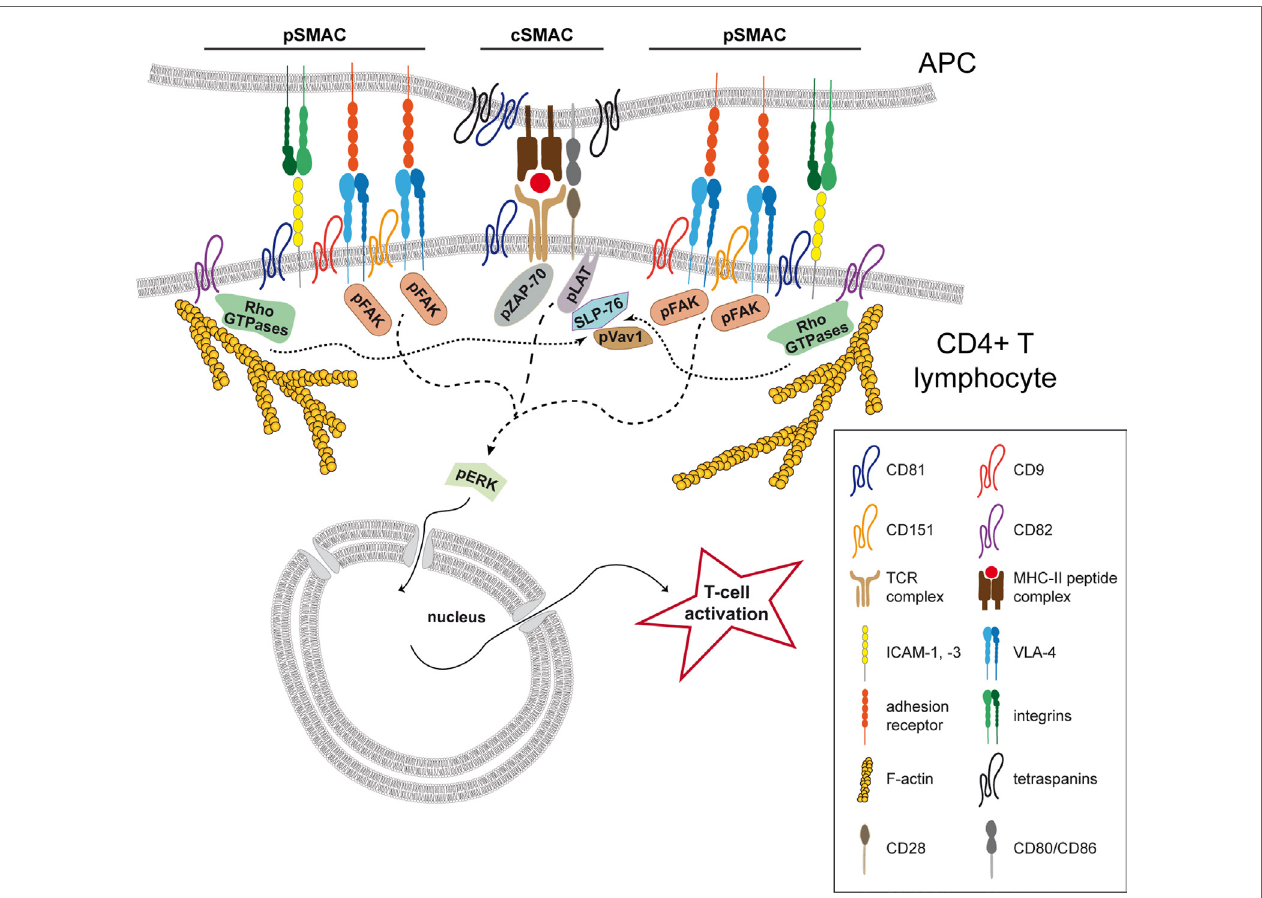
FiGURe 2 | Tetraspanins organize the T-cell immunological synapse . Tetraspanin CD81 regulates the organization of the immunological synapse (IS) in CD4 + T lymphocytes through the association with CD3 ζ at the central SMAC (cSMAC). CD81 controls the localization of the TCR complex and its downstream signaling, positively modulating the phosphorylation of ZAP-70, LAT, and ERK1/2 (dashed line). At the peripheral area of the cell–cell contact (pSMAC), tetraspanins CD9, and CD151 are important for integrin VLA-4 relocalization and activation, positively regulating the integrin downstream phosphorylation of FAK and ERK1/2 (lines with small dashes). At this location, CD81 also interacts with the adhesion receptor ICAM-1, regulating its segregation during IS maturation. Tetraspanin CD82 accumulates at the pSMAC and triggers actin polymerization and the activation of the Rho GTPase pathway (RhoA, Rac1, and Cdc42). The activation of this pathway induces the phosphorylation and the association of Vav1 and SLP76 (dotted lines), potentiating the phosphorylation of the TCR signaling molecules LAT and ZAP-70. In APCs, CD81 is enriched at the IS and several tetraspanins are described to associate with MHC-II. Moreover, CD151, CD37, and Tssc6 were described to regulate antigen presentation by